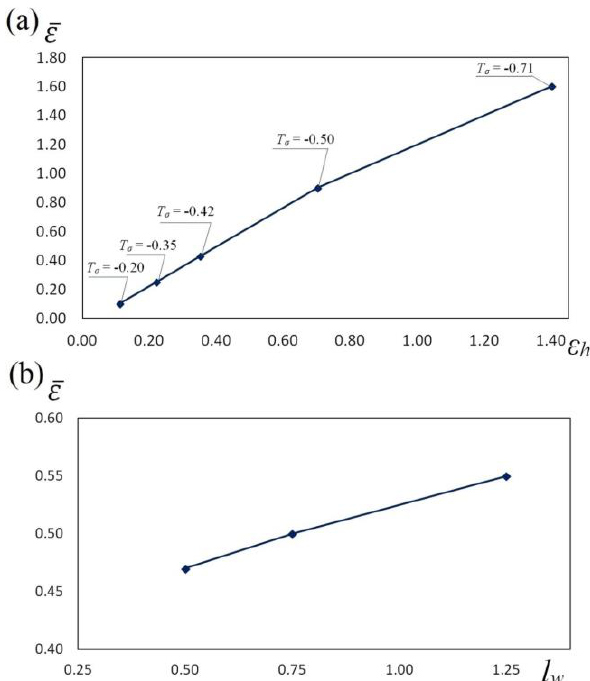
Figure 12. The influence of reduction ratio ( a ) and feed rate ( b ) on the effective strain 𝜀 during the cogging process of the X32CrMoV12-28 die steel specimens in anvils with skew working surfaces: ( a ) feed rate of 0.75; ( b ) reduction ratio of 0.70.